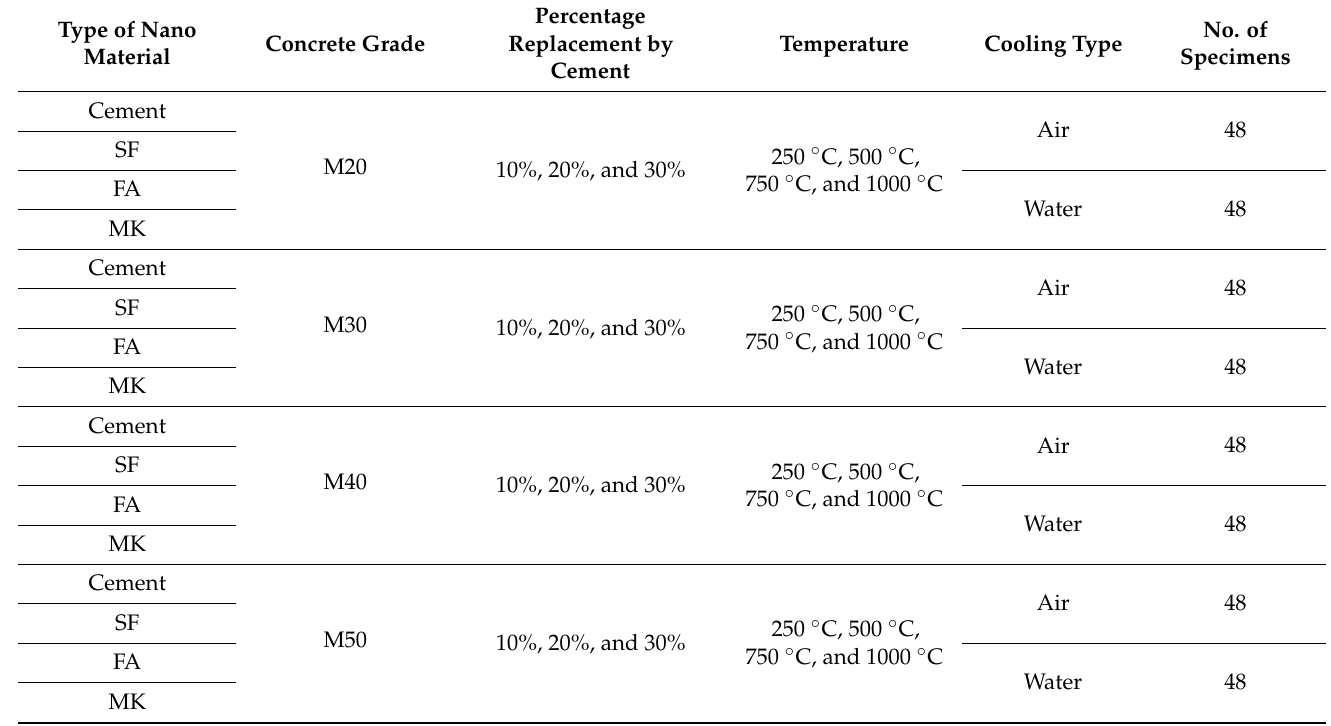
Table 3. Details of cylindrical specimens used for finding impact strength.